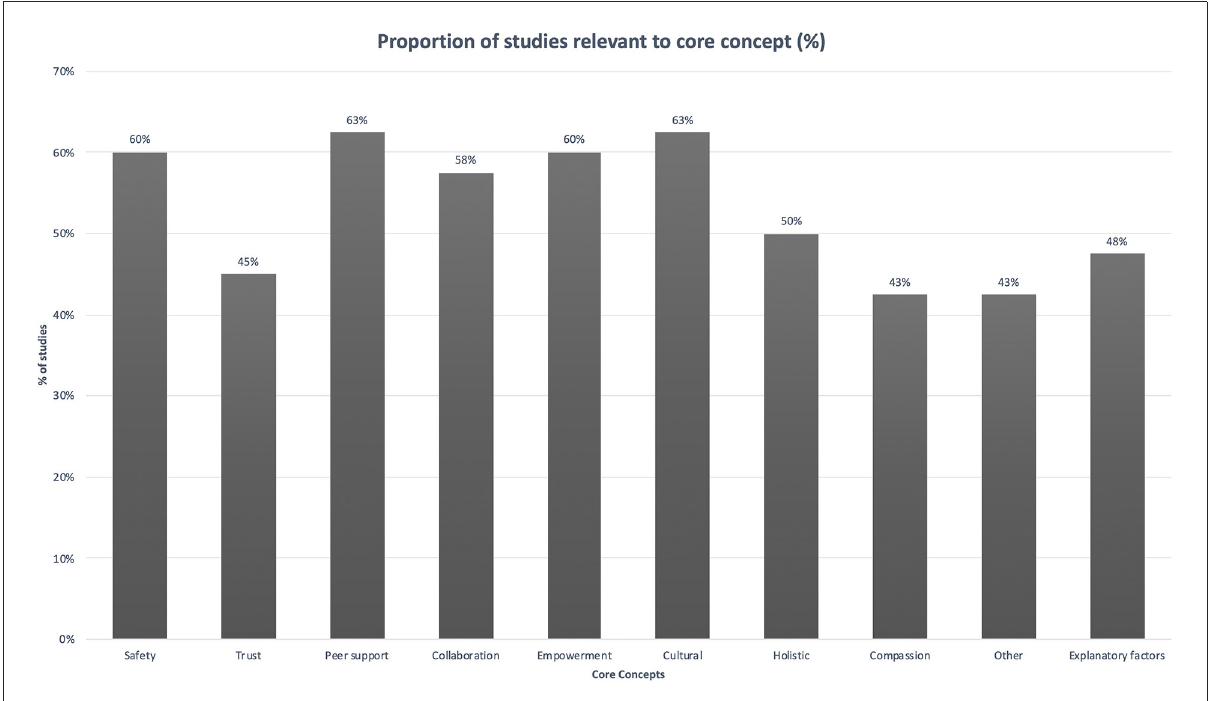
FIGURE2 Proportion of studies with content related to each core concept of the framework